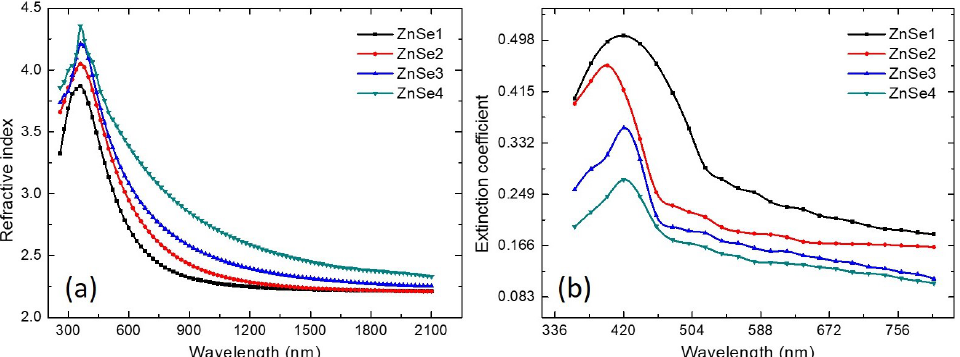
Figure 8. Spectral dependencies of refractive indices ( a ) and extinction coefficients ( b ) of the ZnSe thin films with different thicknesses, prepared by RF magnetron sputtering while varying the RF